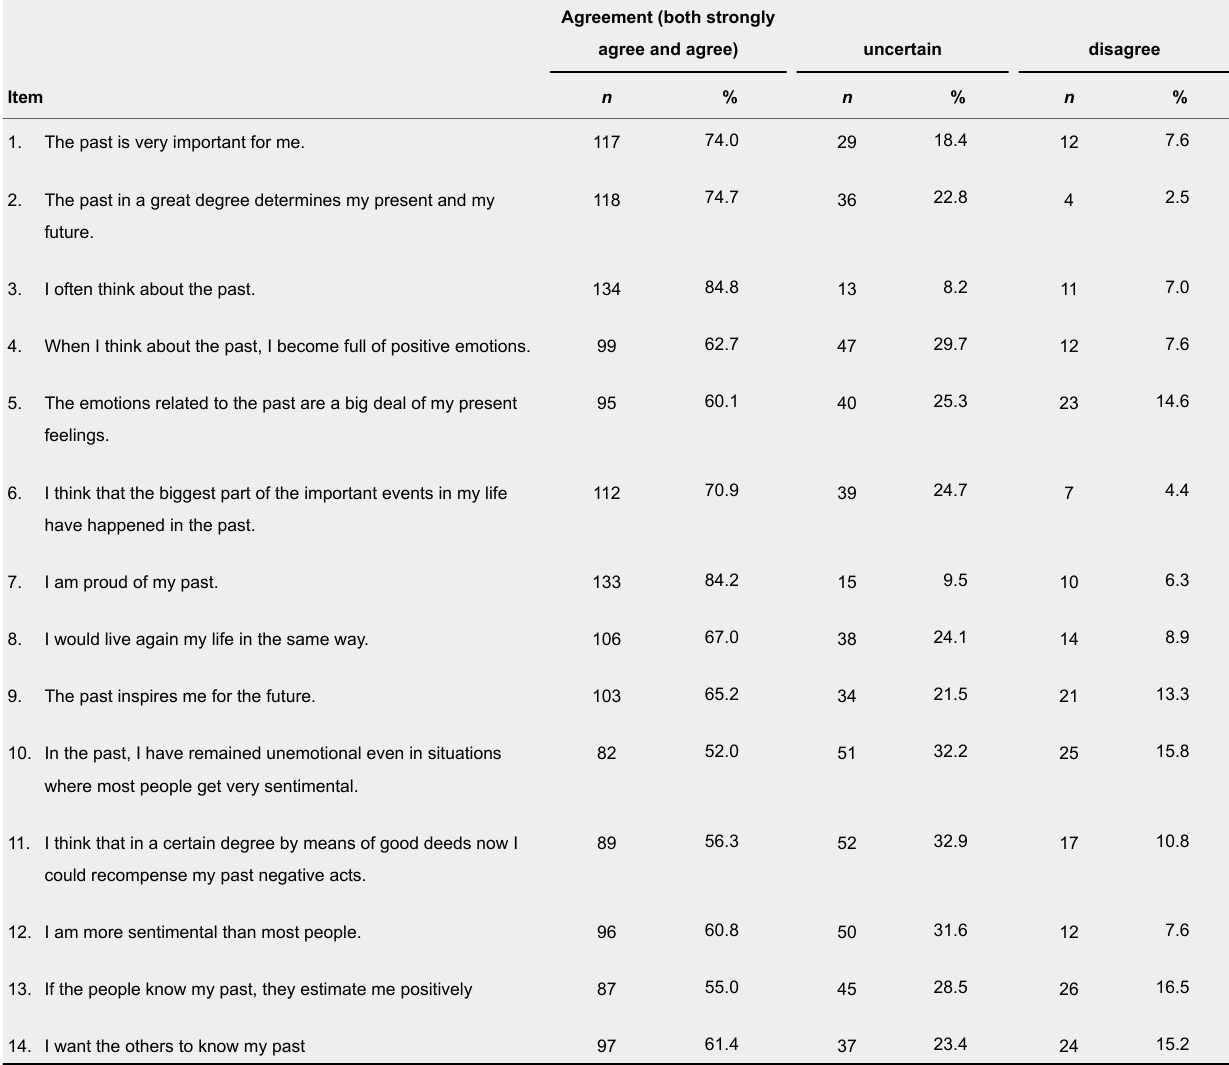
Frequency of Agreement With the Items of the Scale Sentimentality and Nostalgia Related to the Past in Elderly People in